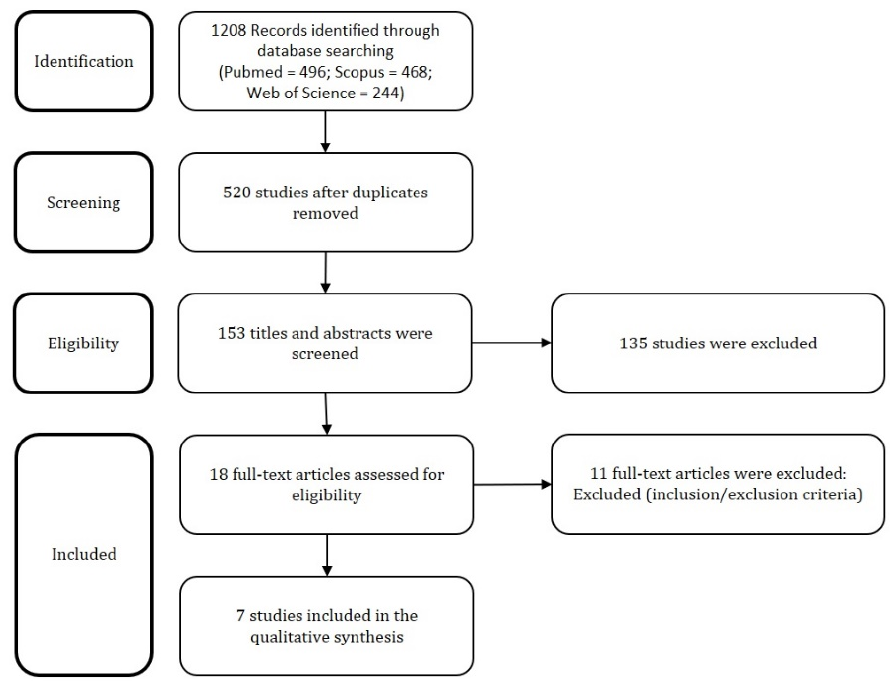
Figure 3. PRISMA (Preferred Reporting Items for Systematic Reviews and Meta-Analyses) flow chart with summary of search results.